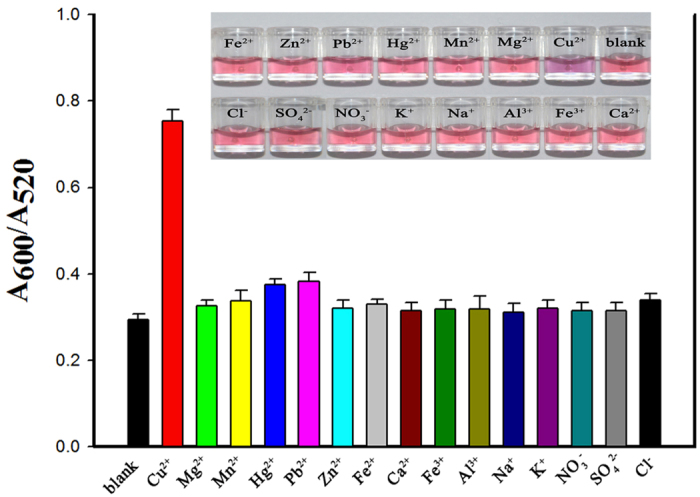
A600/A520 absorbance ratios of multiple antibiotic resistance regulator (MarR)-coated AuNPs (M–AuNPs) on addition of Cu2+ (4 μM), other metallic ions (10 μM; Mg2+, Mn2+, Hg2+, Pb2+, Zn2+, Fe2+, Ca2+, Fe3+, Al3+, Na+, K+) or environmental anions (1 mM; NO3−, SO42−, Cl−). Error bars at n = 3.The inset shows the corresponding photographic images of the M–AuNP solutions.